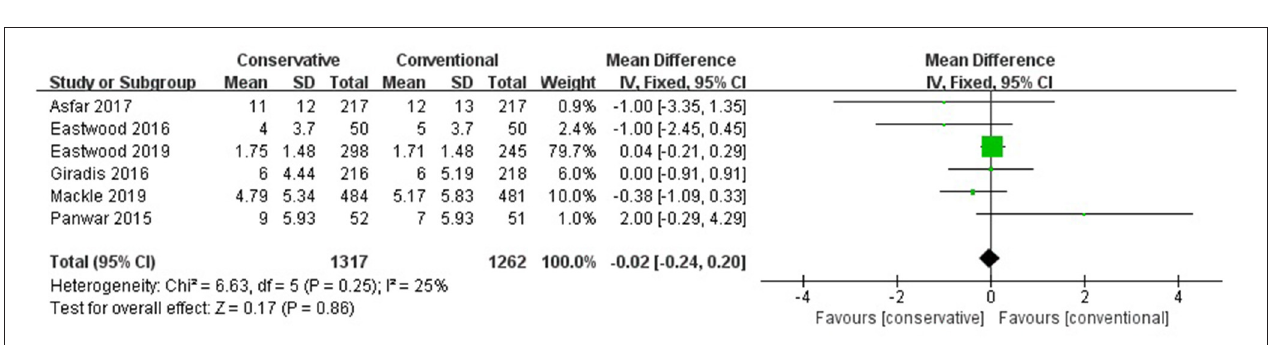
FIGURE 3 | ICU LOS. CI, confidence interval; ICU, intensive care unit; LOS, length of stay; MD, mean difference; SD, standard deviation.